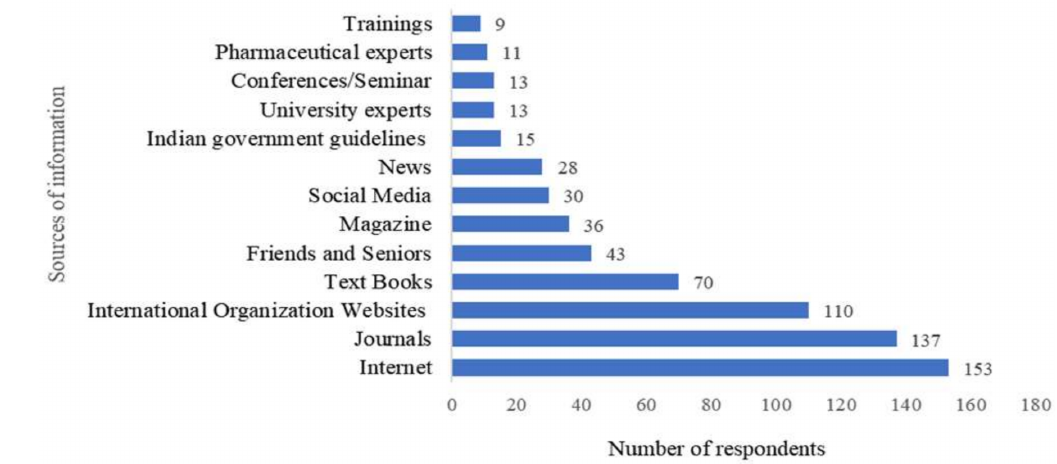
Figure 4. Information sources referred by veterinarians on antibiotic use and resistance * (* Question: What are the major information sources that you refer regularly to for knowledge on antibiotic use and resistance? (The question was open-ended with the provision to answer more than one source of